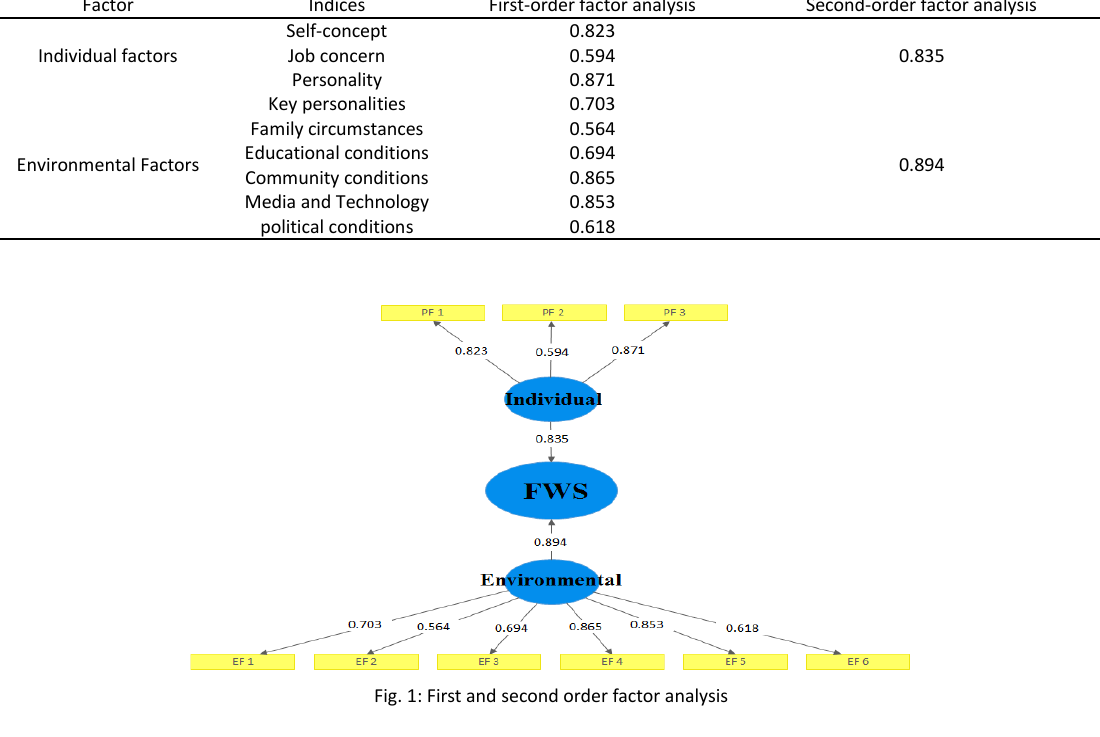
Table 5: Confirmatory factor analysis of the first and second order